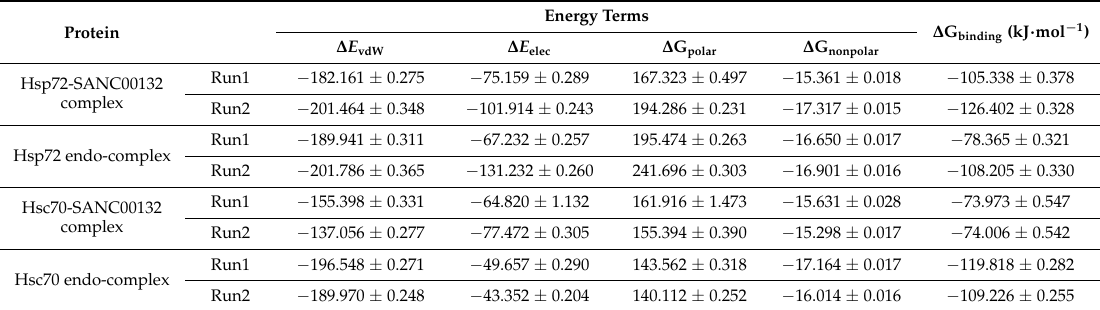
Table 1. Total binding free energy results. Tabulated summary of energy term contributions and the resultant total binding free